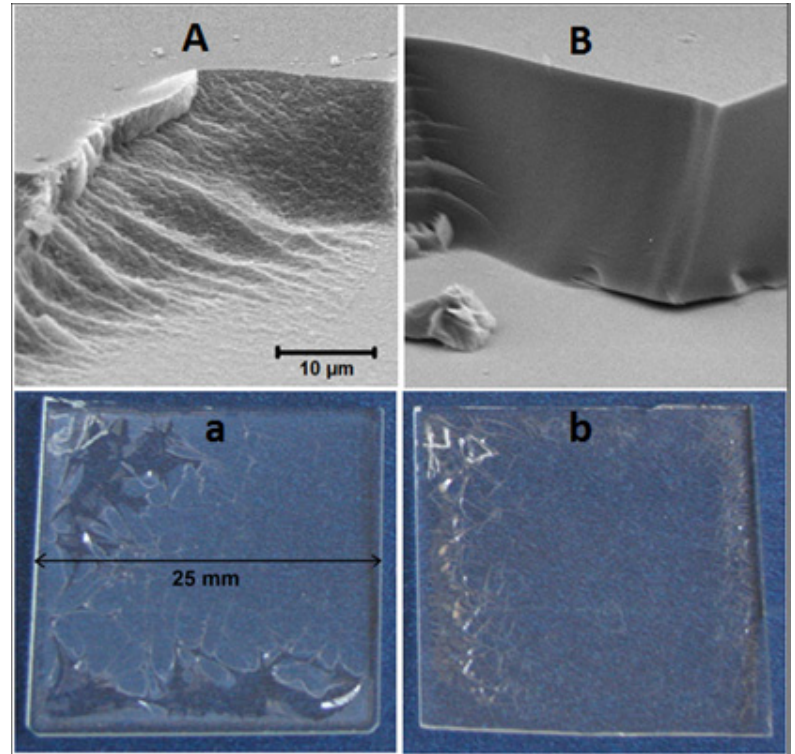
Figure S1. Morphology of MIP films prepared without polyethylene glycol (PEG) and polyvinylacetate (PVA). MIP 1 (no PEG): ( A ) SEM image, ( a ) photo; composition